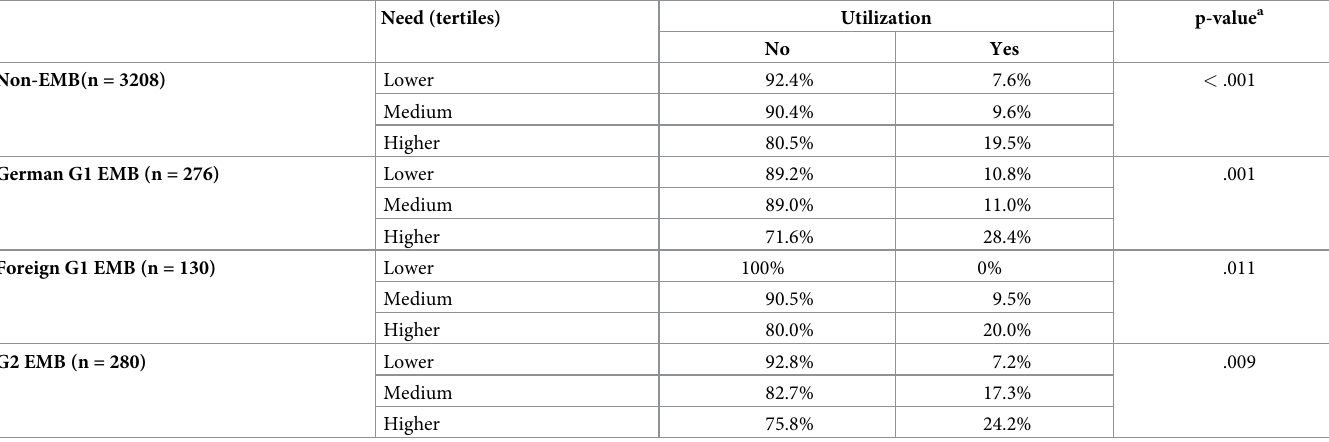
Table 4. Utilization of rehabilitation services depending on the need for rehabilitation (separated for each group, weighted results, row percent, n =